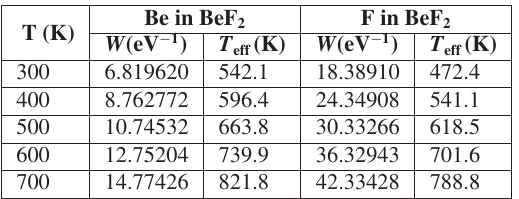
Figure 5. The thermal neutron scattering cross sections of BeF 2 at 300K. Table 3. Effective Temperatures and Debye- Waller integrals divided by the atomic mass for BeF 2